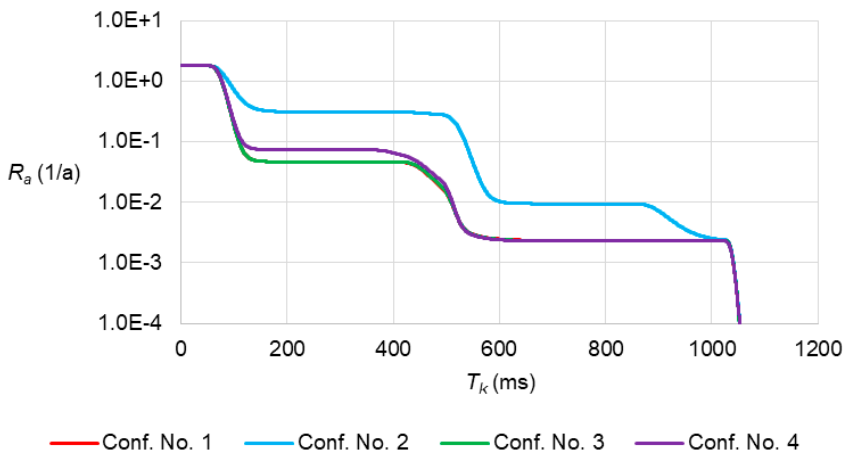
Figure 11. Expected annual frequency of exceeding actual values of short circuit duration at inspection point A on substation bus bar.